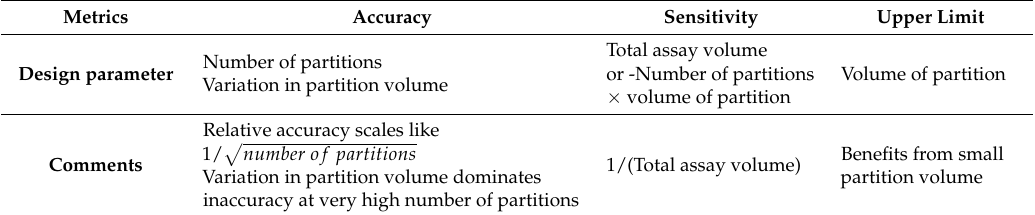
Table 1. Design parameters and performance metrics of